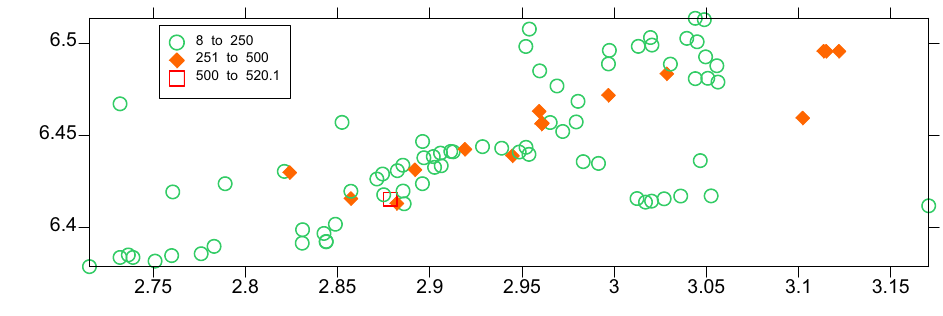
Fig. 21 Classed map of